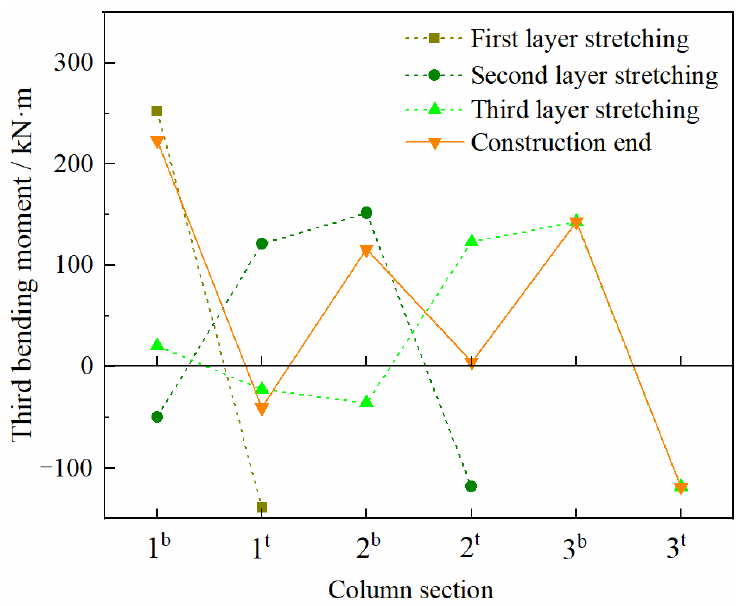
Figure 14. The third moment of the layer-by-layer stretching plan.